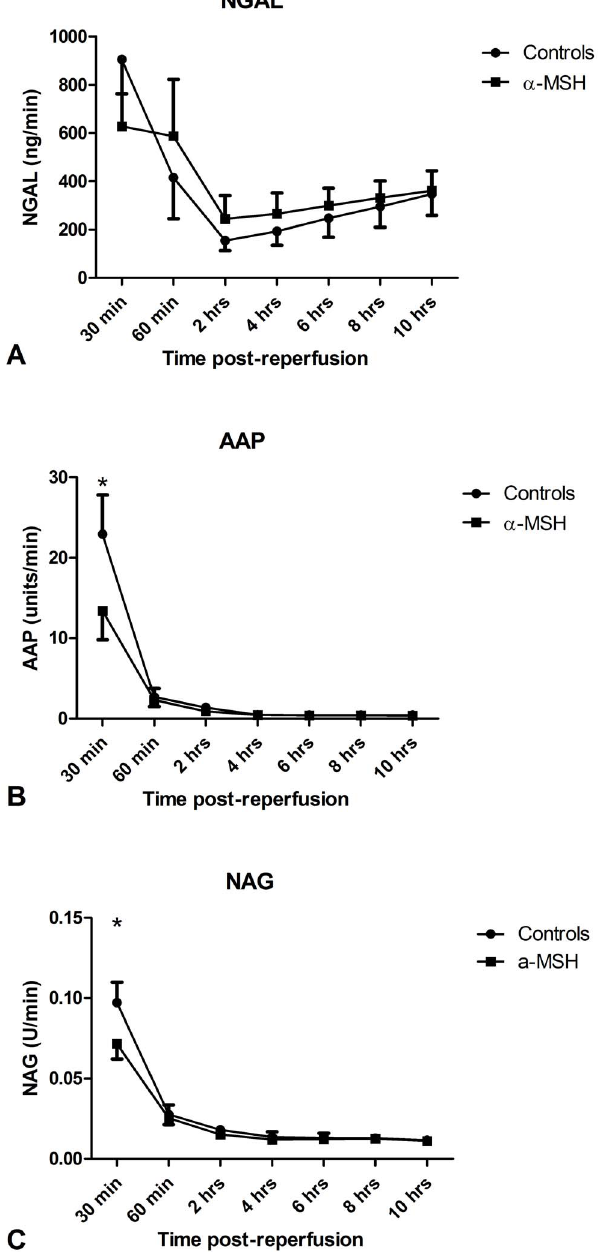
Figure 8. Effect of a -MSH on urinary markers of acute renal injury. a -MSH significantly reduced AAP and NAG excretion in the first thirty minutes (Figure 8B and 8C; *=p , 0.05).